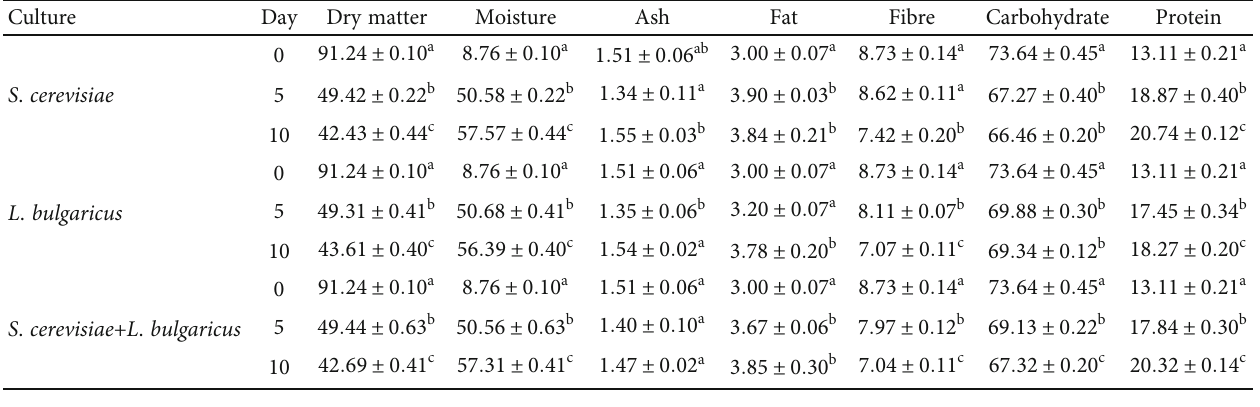
Figure 2: Process fl ow diagram of the solid-state fermentation method of unmalted sorghum (black vessels) and malted sorghum (orange vessels) with monocultures of S . cerevisiae and L . bulgaricus and coculture of S . cerevisiae and L . bulgaricus . Initial nitrogen (% N of unfermented unmalted and malted sorghum substrates, not inoculated with either S . cerevisiae or L . bulgaricus (controls), were determined at day 0 by the Kjeldahl method. Table 2: Changes in the chemical composition of fermented, unmalted sorghum with monocultures of S . cerevisiae or L . bulgaricus and a coculture of S . cerevisiae and L . bulgaricus (data presented are based on the dry matter). a – c Means within a column with di ff erent superscripts are signi fi cantly di ff erent ( p ≤ 0 : 05 ). Results expressed as mean ð n = 3 Þ ± SD (standard deviation).